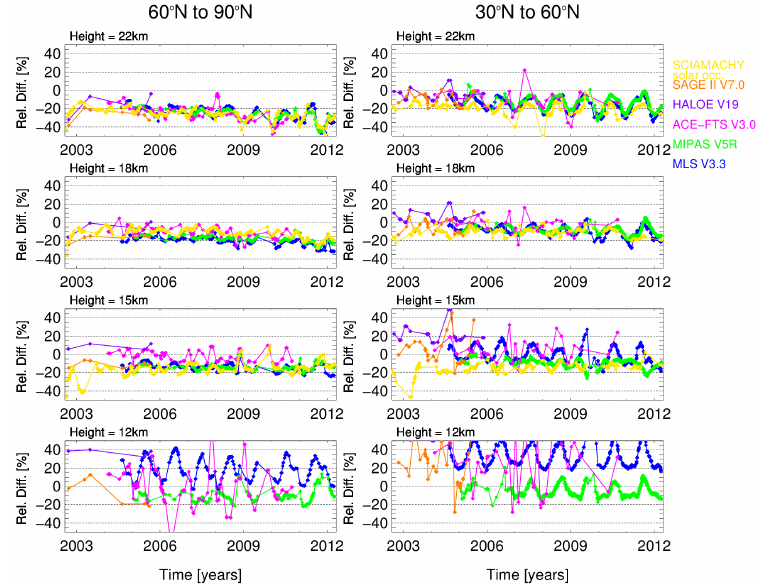
Figure 17. 30-day running mean time series of the mean percentage difference between SCIAMACHY and other satellite water vapour profiles smoothed with the AVK of SCIAMACHY (Eq. 4) for different altitudes for polar (left panels) and middle latitude regions (right panels) in the